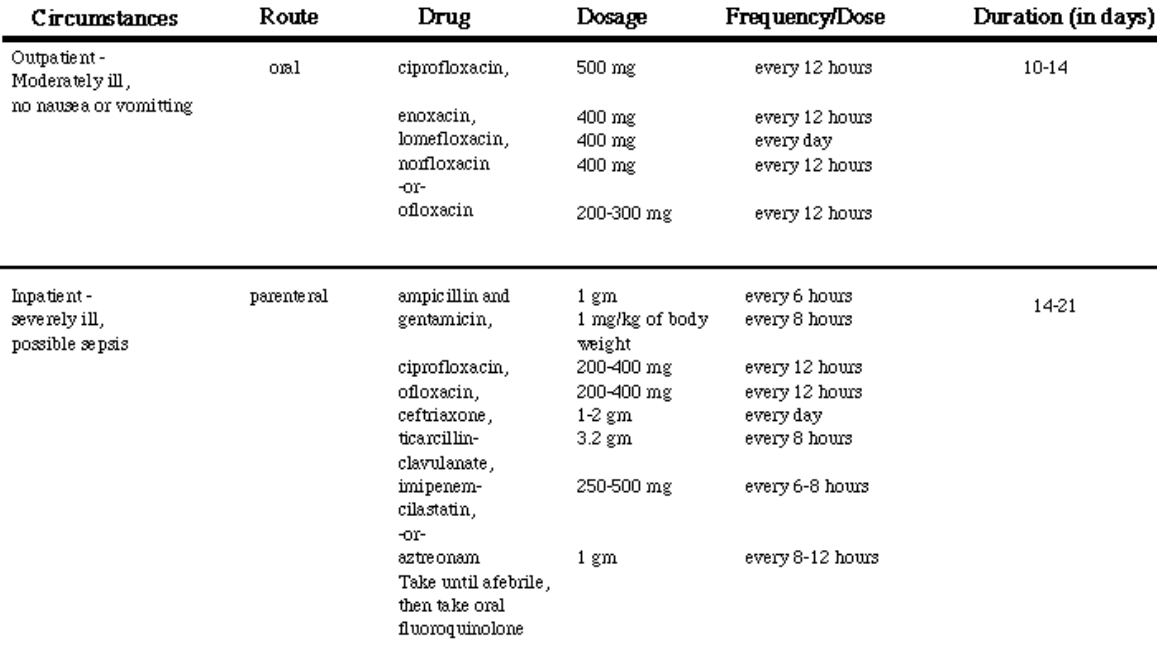
Treatment Regimens for Complicated Urinary Tract